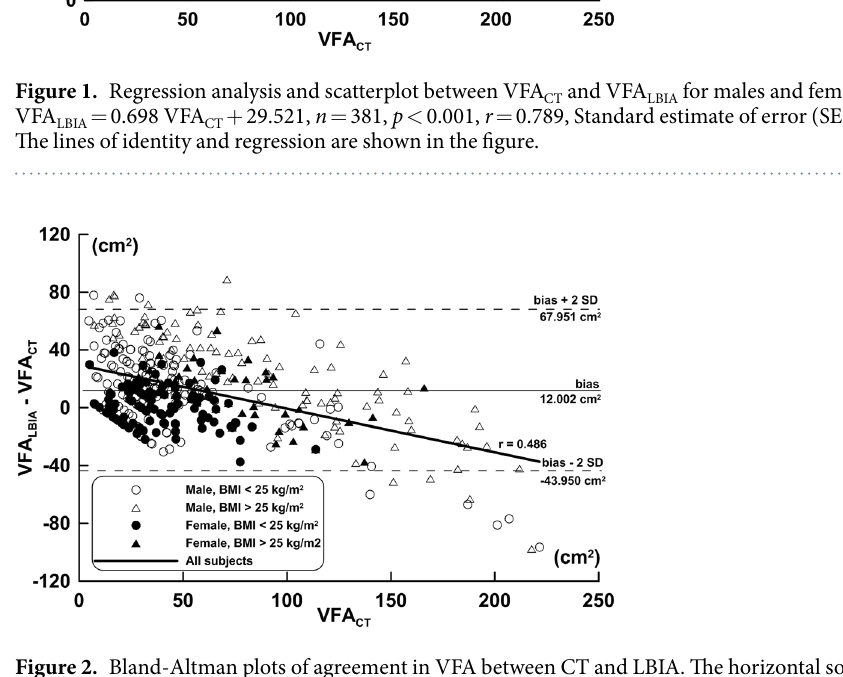
Figure 2. Bland-Altman plots of agreement in VFA between CT and LBIA. The horizontal solid line represents the mean difference bias between the two measuring methods. The upper and lower dotted lines represent bias ± 2 SD. The linear line is the regression line (y = − 0.301 x + 29.521, r = 0.486, p < 0.001, bias = 12.002 cm 2 , bias – 2 SD = − 43.950 cm 2 , bias + 2 SD = 67.951 cm 2